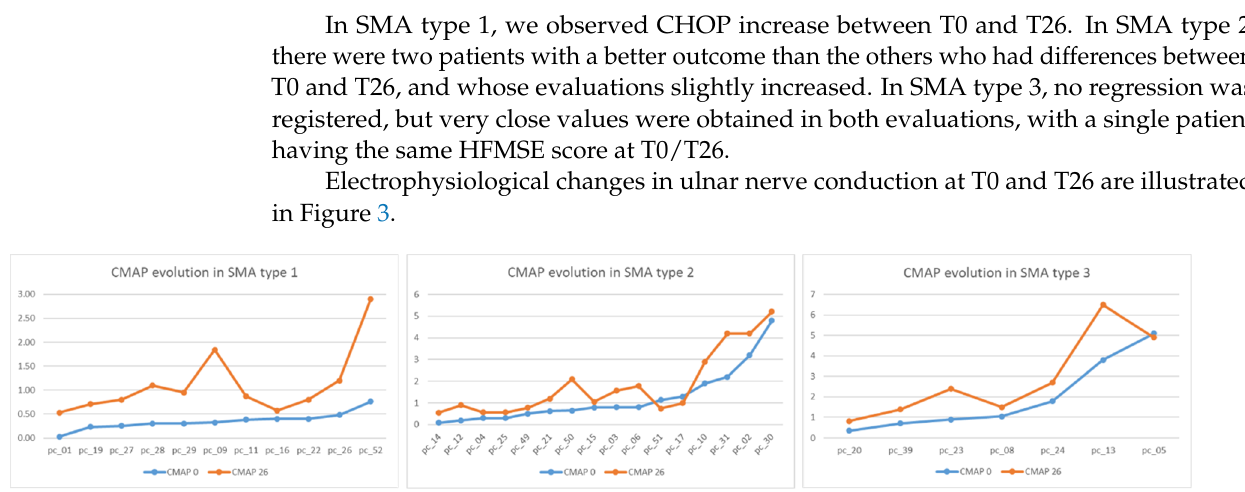
Figure 3. CMAP evolution at T26 for each type of SMA.